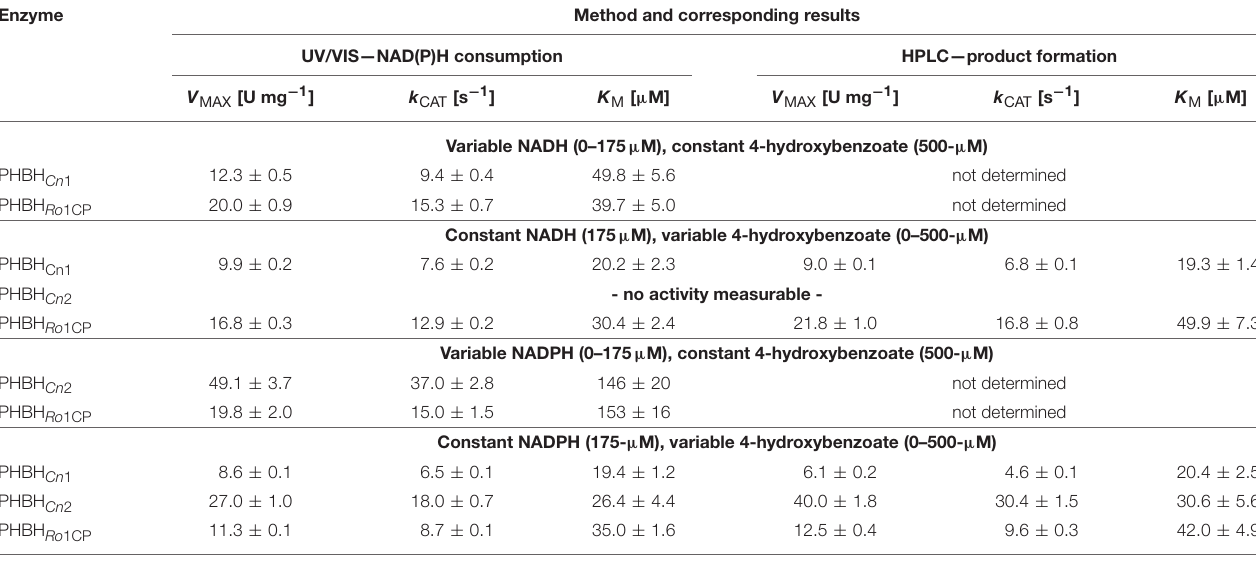
TABLE 2 | Apparent steady-state kinetic parameters of newly produced PHBH enzymes. Enzyme Method and corresponding results